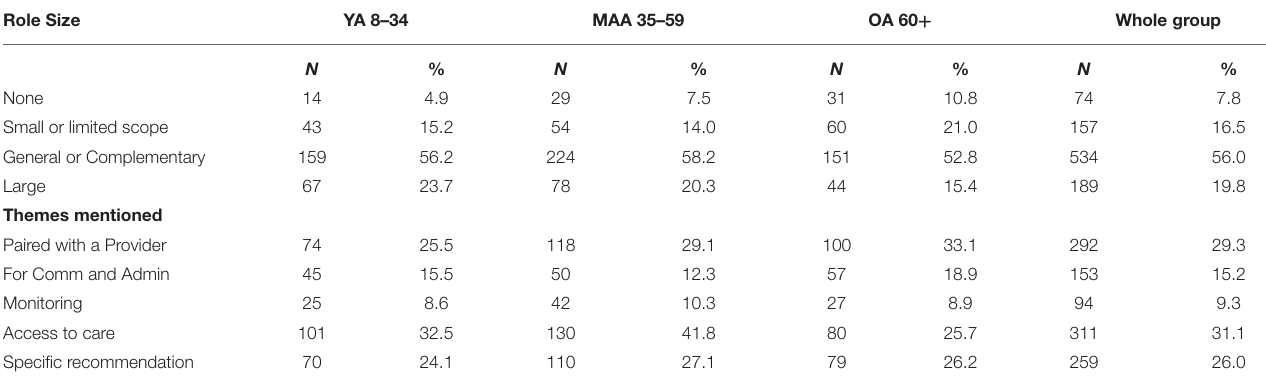
TABLE 4 | Role size and themes mentioned in qualitative